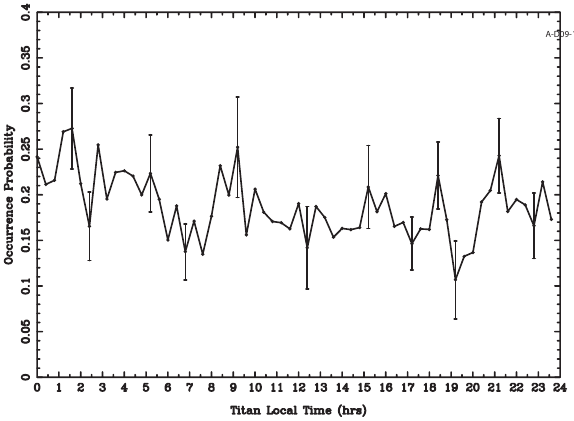
Fig. 3. The occurrence probability versus Titan local time with the Figure 3 OP averaged over the range, 42 ◦ < SHL < 180 ◦ . The representative error bars on a number of points have a length of 2 σ